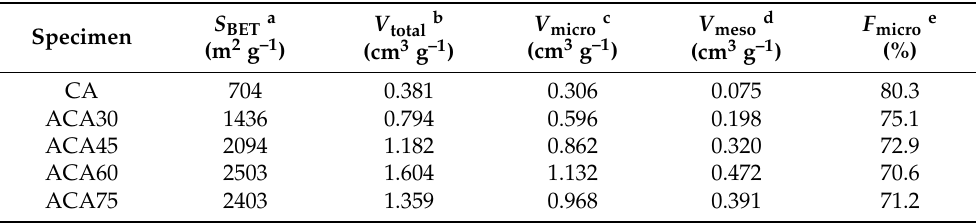
Table 1. Textural properties of prepared